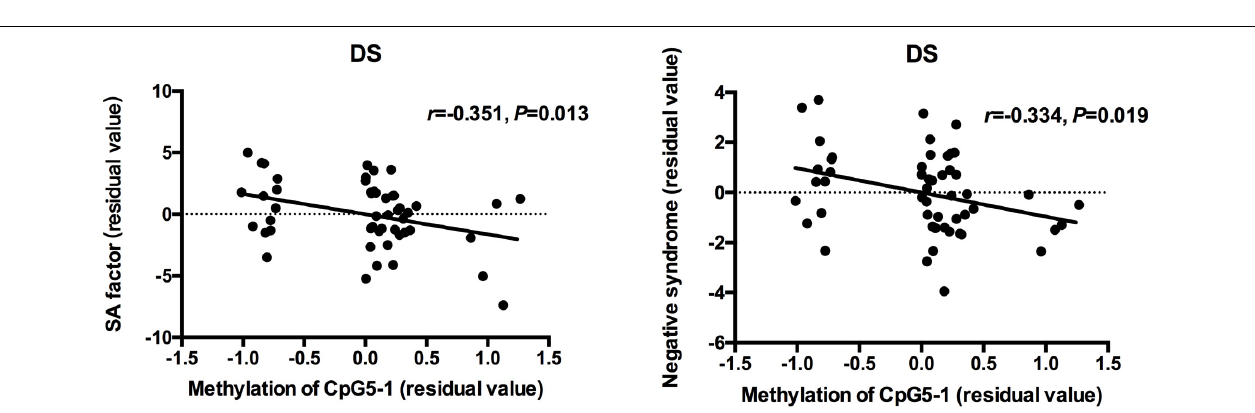
FIGURE 1 | Correlation between MMP9 expression and methylation in exons 4 and 5. The points of the scatter plot represented residual value of mean methylation of exon 4/exon 5 and relative fold changes of MMP9 (gene expression) after controlled covariates in DS (filled dots) and NDS (empty dots) groups. The mean methylation was calculated by using the relative methylation changes in each CpG site.